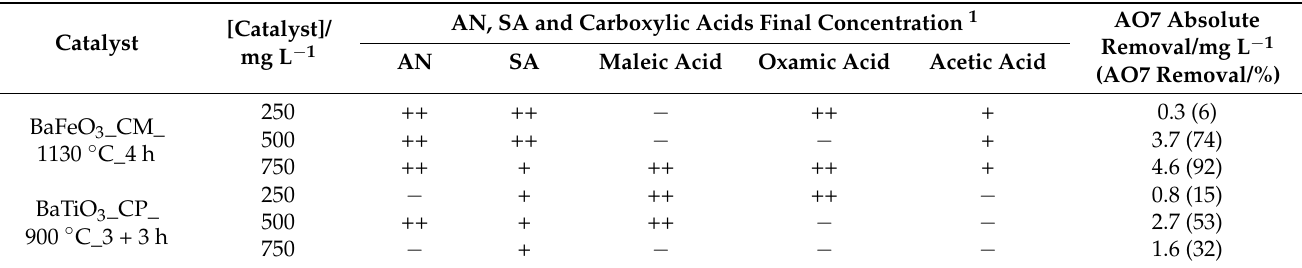
Table 4. Results from photocatalysis with different perovskites at different concentrations with sunlight: [AO7] 0 = 5 mg L − 1 ; Volume = 50 mL; Assay duration—4